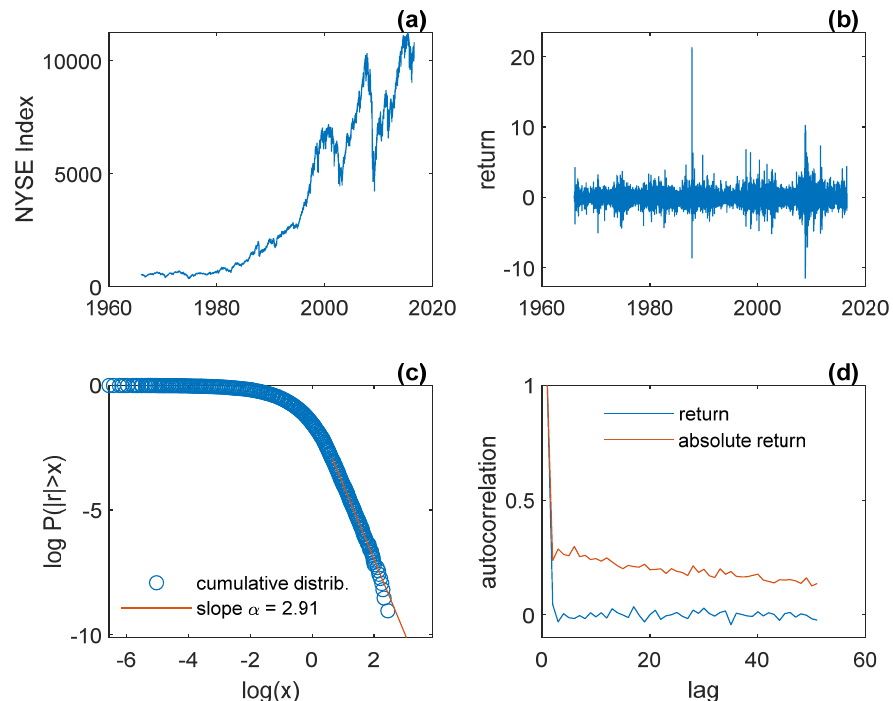
Figure 2. New York Stock Exchange (NYSE) composite daily index. ( a ) index; ( b ) return; ( c ) tail; ( d ) autocorrelation function of return and absolute return.